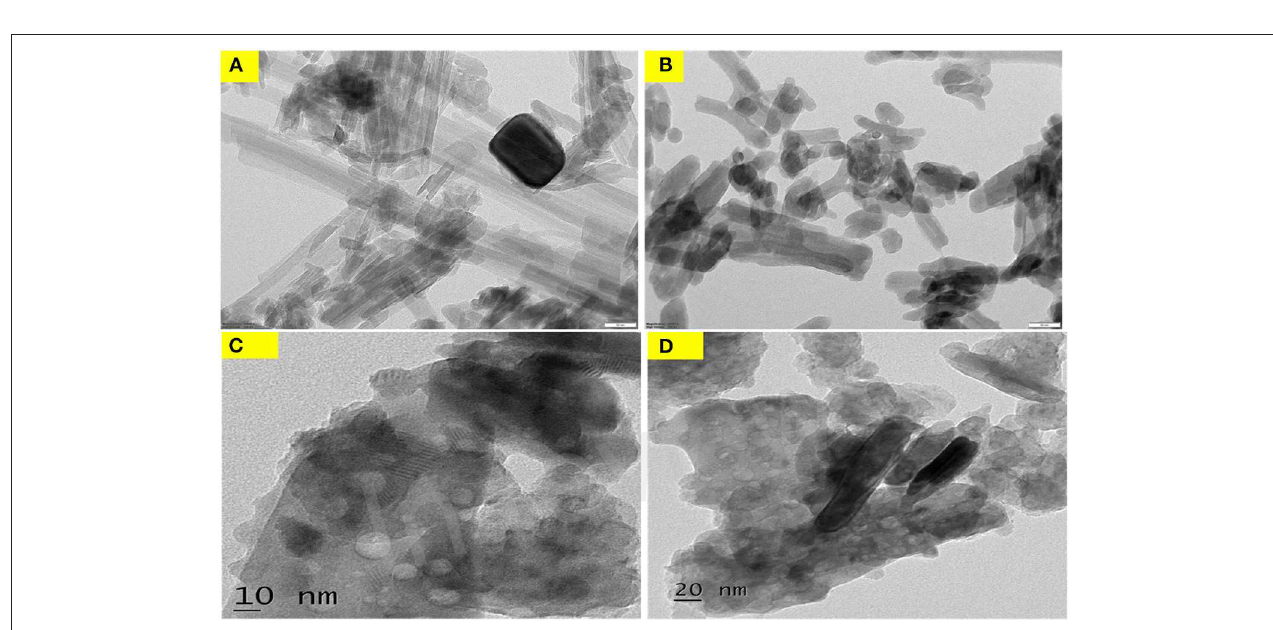
FIGURE 7 | TEM images of (A,B) PTSp/ZnO, (C,D) S/PTSp/ZnO. absorption peaks of the wurtzite period of Zn-O. These results verify the event of Zn-O groups. 3,420 cm − 1 can be credited to the O-H stretching of the water. 2,927 cm − 1 are allocated to the